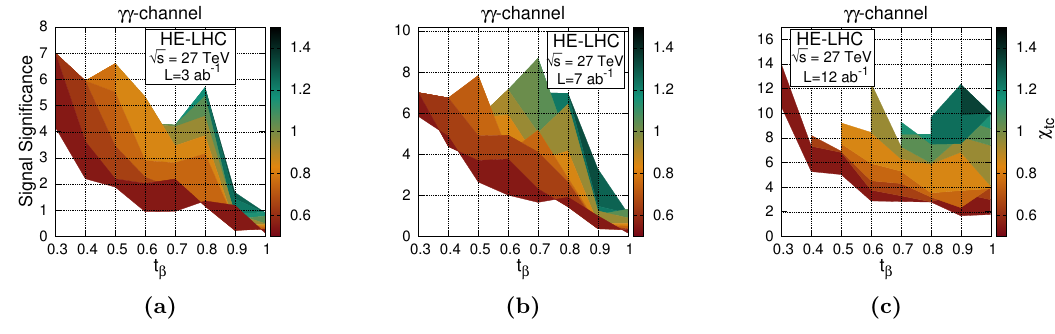
Figure 8. The same as in (cid:12)gure 7 but for: (a) L =3 ab (cid:0) 1 , (b) L =7 ab (cid:0) 1 , (c) L =12 ab (cid:0) 1 . The case (c) represents the (cid:12)nal integrated luminosity reached by the HE-LHC.